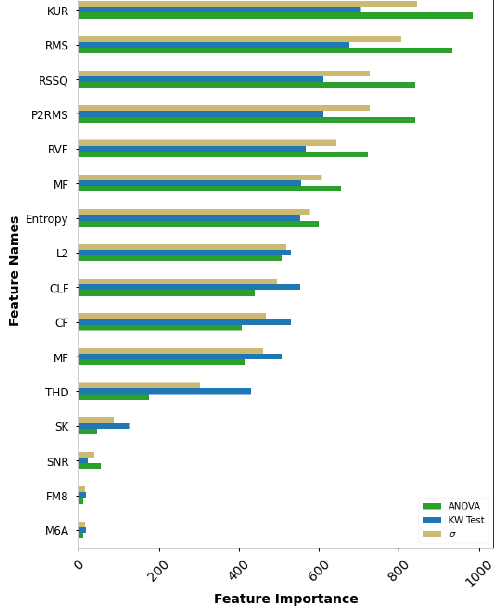
score score 𝝈𝝈 𝝈𝝈